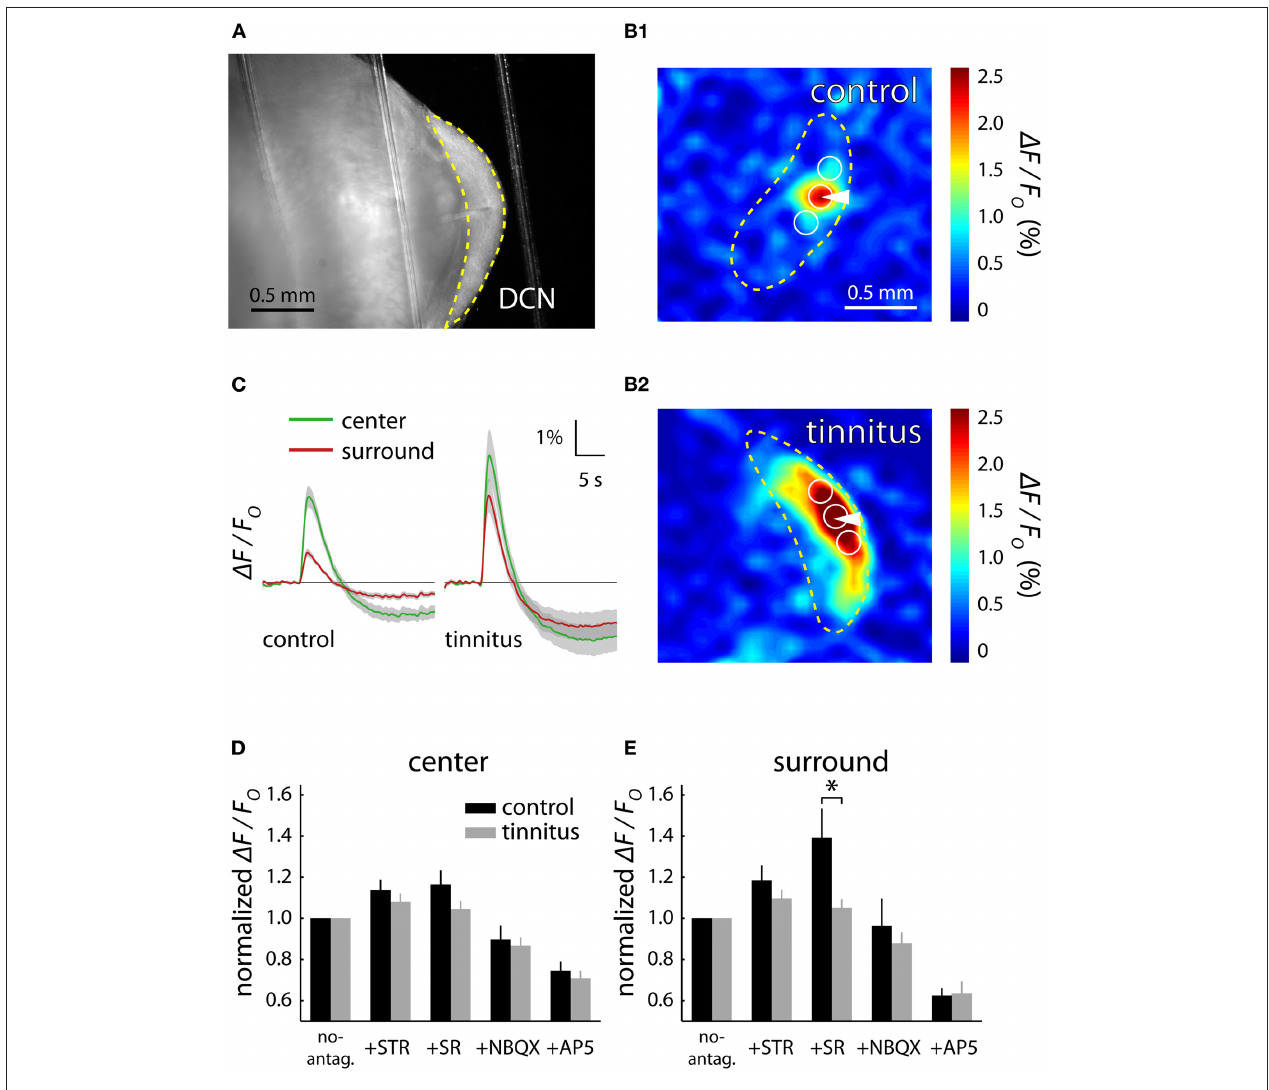
FIGURE 4 | Flavoprotein autofluorescent (FA) imaging reveals GABAergic related hyperactivity in the dorsal cochlear nucleus (DCN) of mice with behavioral evidence of tinnitus. Electrical stimulation of the DCN brain slices (A) leads to a spatially concise excitatory response in control animals (B1) and a spatially extended response in tinnitus animals (B2) . The center region is defined as the area at the stimulation electrode while the surround regions flank the center on either side along the fusiform